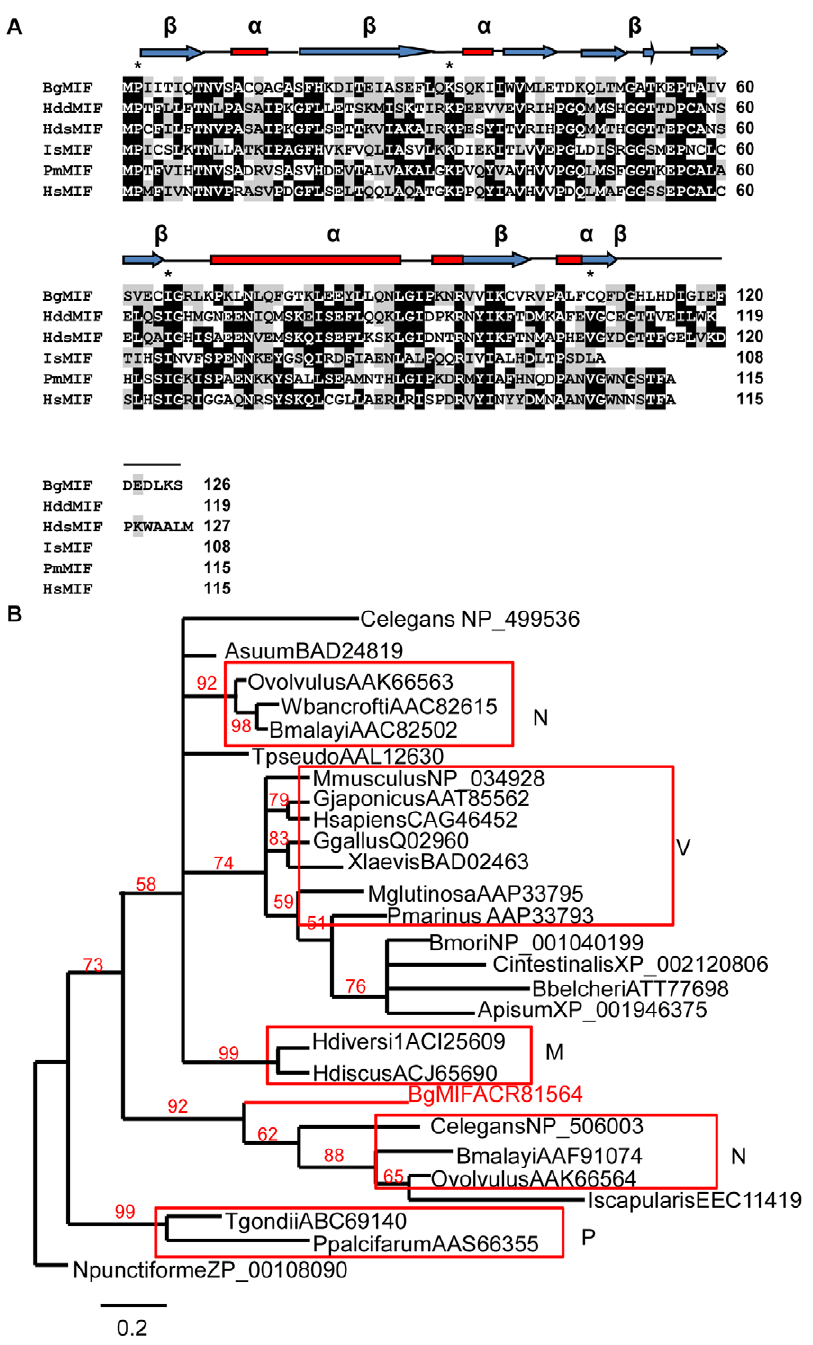
Figure 1. BgMIF is a variant member of the MIF family. (A) Alignment of the BgMIF (BgMIF; accession number: ACR81564) peptide sequence to MIFs from Haliotis discus discus (HddMIF; accession number: FJ435176), Haliotis diversicolor sextus (HdsMIF; EU284114), Ixodes scapularis (IsMIF; EEC11419), Petromyzon marinus (PmMIF; accession number: AA833793) and Homo sapiens (HsMIF; accession number: NM_002415). Residues conserved in the tautomerase catalytic site are marked with a star. Putative protein secondary structure ( a = a -helix, b = b -sheet) according to (11) is shown above the sequence alignment. (B) Maximum-likelihood tree of BgMIF and MIF proteins from selected species (Genbank accession numbers and name of species are shown on the tree). The tree obtained using MrBayes is shown (see methods). Numbers above branches are Bayesian Posterior Probability values (100000 replicates). Horizontal distances are proportional to percents of divergence between tip species and nodes (scale given), vertical distances are arbitrary. Only BPP values . 0.5 are shown. M, Mollusks; N, Nematodes; P, Protozoans; V, Vertebrates.